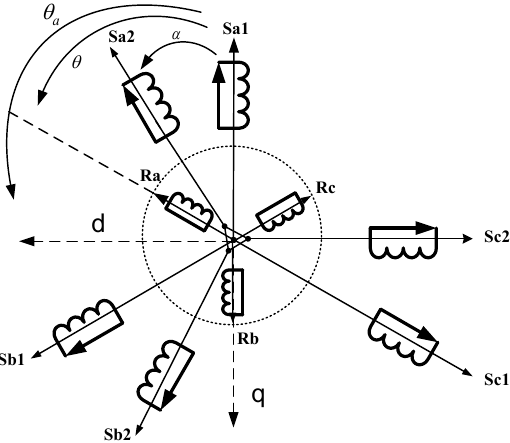
Figure 1. Equivalent six-phase induction machine scheme.